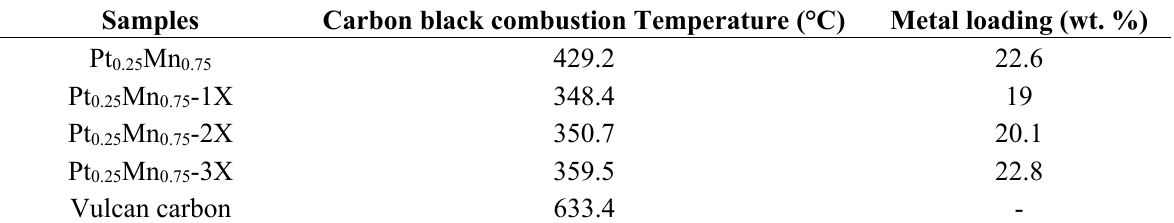
Figure 2. The effect of sodium citrate concentration on the weight loss of Pt-Mn alloys, which were synthesized on Vulcan carbon support. Table 2. The metal loading and the Vulcan carbon combustion temperature measured from Figure 2.